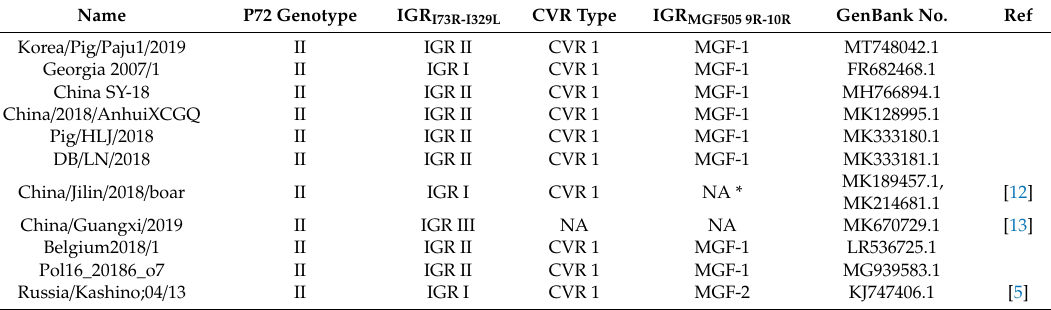
Figure 4. Intergenic region (IGR) of MGF 505 9R / 10R analysis of ASFV isolated in domestic pigs of South Korea, 2019. Table 2. Comparison of molecular characterization between ASFV genotype